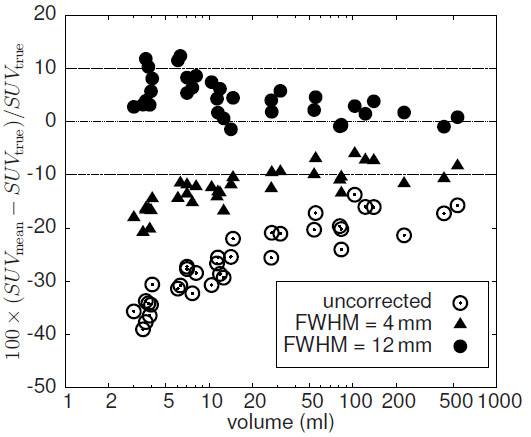
Difference between LBPVC-corrected and true SUVmeanusing automatic ROI delineation for different values of the assumed spatial resolution (at a noise level of FWHM = 5%). Note the logarithmic scale of the abscissa.